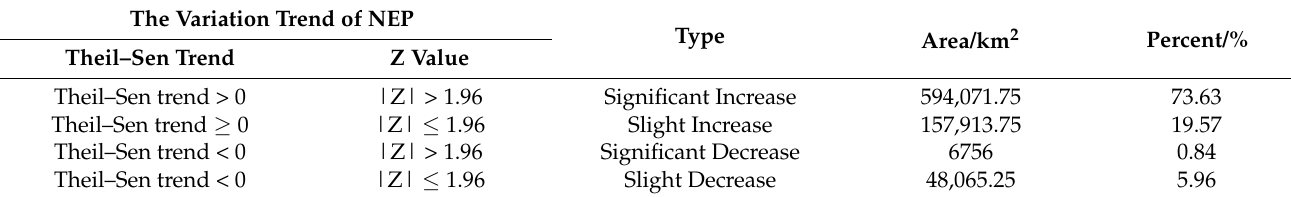
Table 1. The variation trend of NEP in the Yellow River